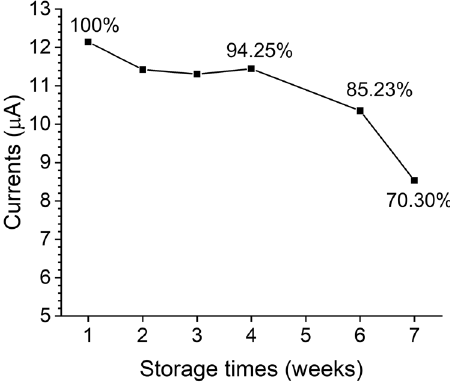
Fig. 6 The performance of stability of the paper-based immunosensor. The fi gure showed the lifetime of several devices stored at 4 °C before the devices were invalid. When the peak current dropped 20%, we considered the device